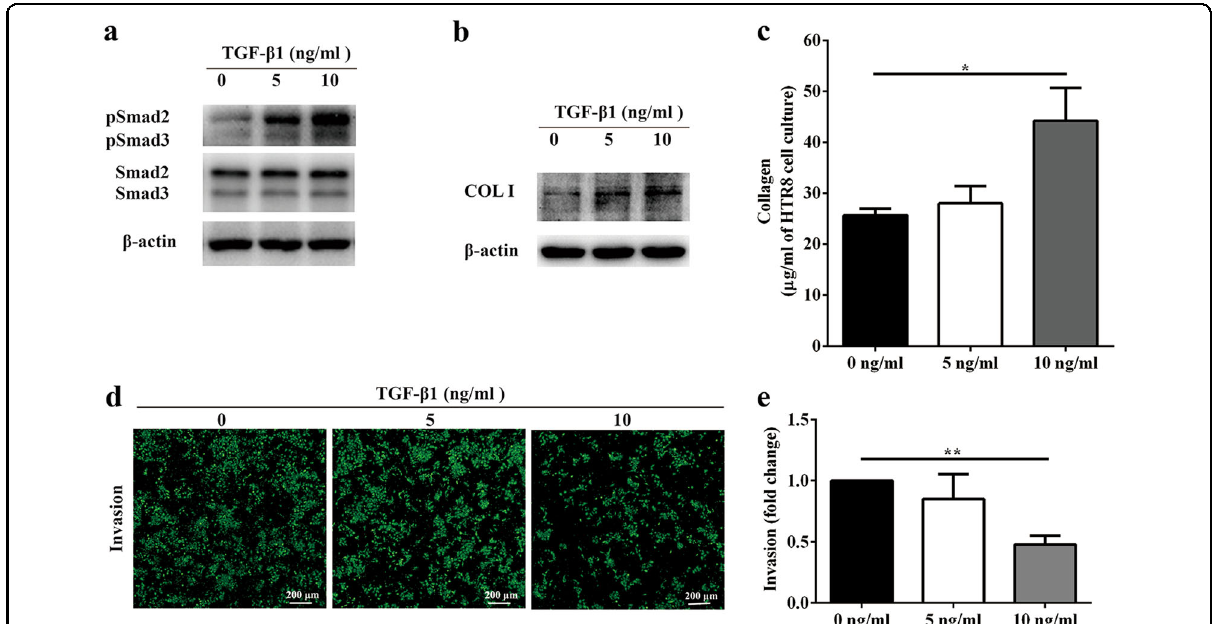
Fig. 6 Exogenous transforming growth factor- β 1 (TGF- β 1) treatment reduced trophoblast cell invasion. a Western blot analysis of pSmad3 and Smad3 in HTR-8/SVneo cells stimulated by exogenous TGF- β 1. b Western blot analysis of type I collagen production in HTR-8/SVneo cells stimulated by exogenous TGF- β 1. c Amount of soluble collagen from cell culture supernatants was quanti fi ed using a sircol collagen assay. Data are presented as the means ± SEM of three independent experiments. d Invasion of HTR-8/SVneo cells upon TGF- β 1 treatment was determined by Transwell assays. Representative images are shown. e Relative fold changes in cell invasion were calculated. Statistical data were analyzed by Student ’ s t -test. Data are presented as the means ± SEM of three independent experiments. * P < 0.05 and ** P <